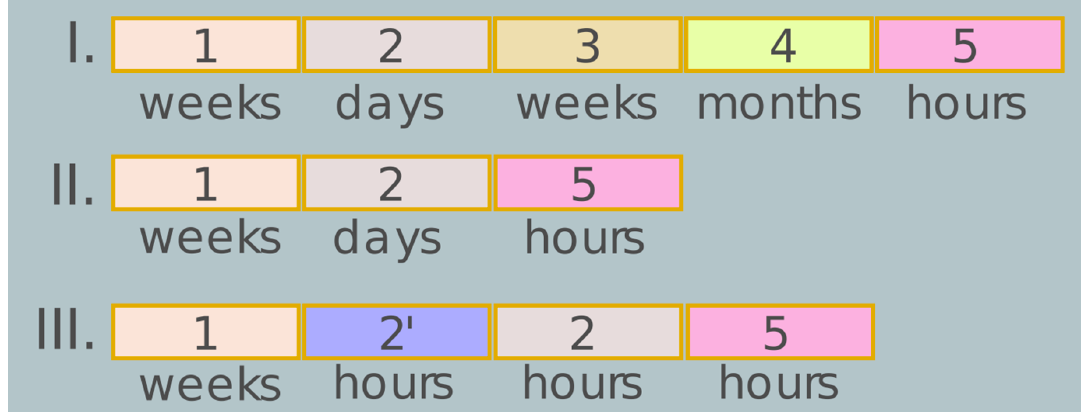
Figure 1. Comparison of the methods for agrobacterial plant transformation ( I ), agroinfiltration ( II ) and protoplast transfection ( III ). Rectangles of the same color and numbers denote the common stages. Time scale is shown below.